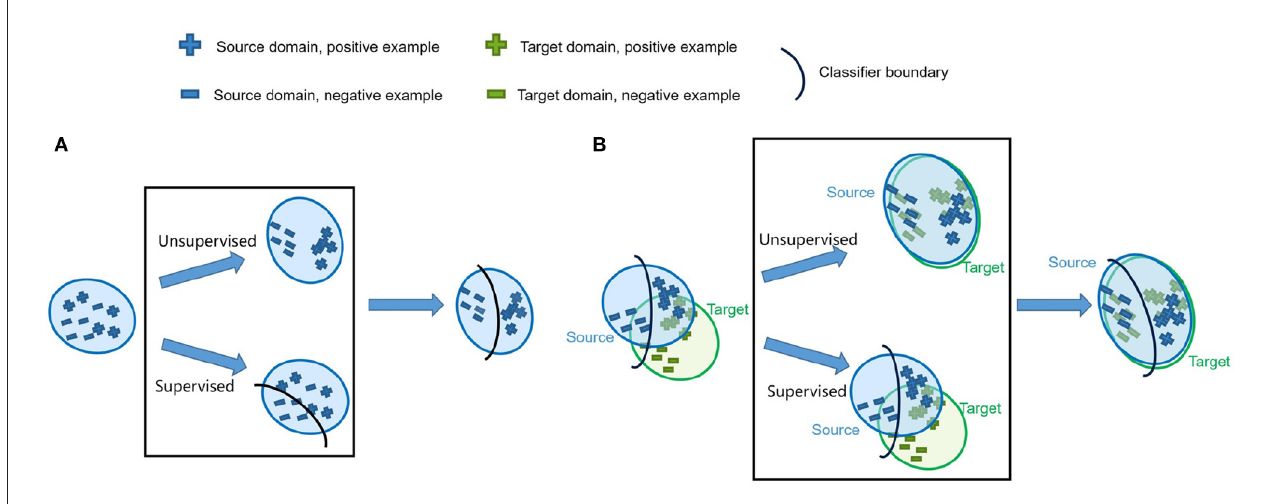
FIGURE 1 | (A) Overview of the proposed semi-supervised segmentation approach. We utilize an unsupervised loss to obtain a better representation for the radiographs and a supervised loss to relate those features to the segmentation task. (B) Overview of the proposed unsupervised domain adaptation (UDA) segmentation approach. We leverage U-shaped GAN to find a better representation with basic features supporting radiograph imaging with an unsupervised loss. The distributions of the source and target data are aligned in this representation.